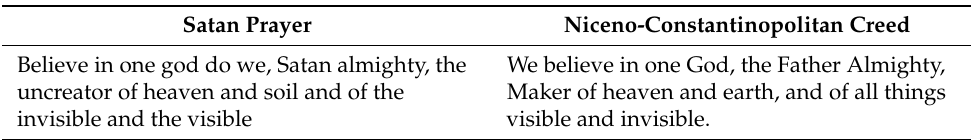
Table 1. The lyrics of “Satan Prayer” compared to the Niceno-Constantinopolitan